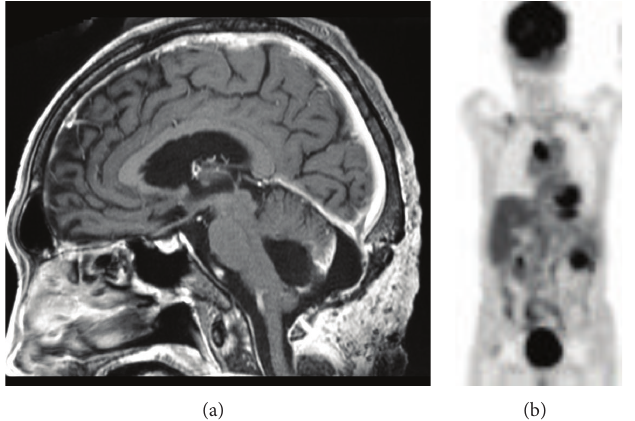
Figure 4: Postoperative MRI shows medulla decompressed without the residual tumor in the vermis (a). Positron emission tomography (PET) reveals abnormal accumulations in the cardiac apex, subclavial region, and peritoneal cavity (b).